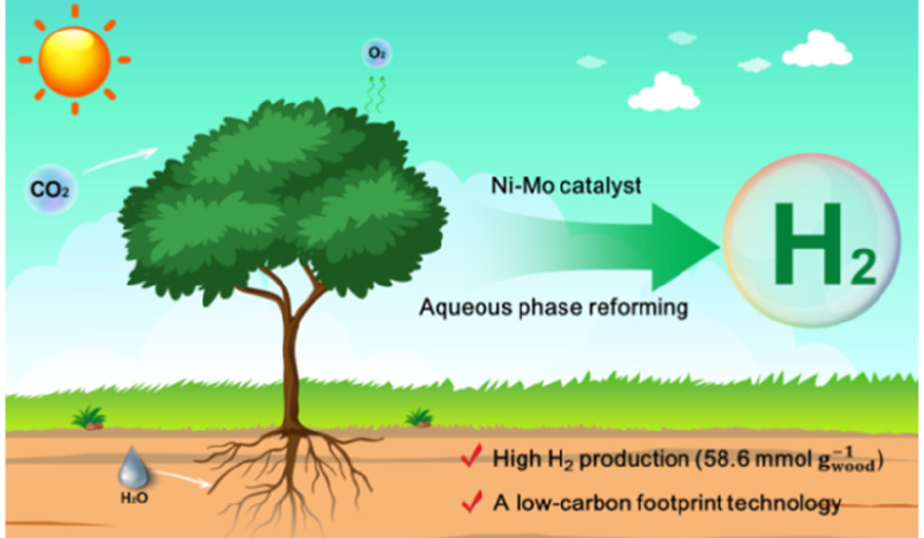
Figure 1. Low-temperature efficient hydrogen production from raw biomass on the Ni–Mo catalyst. reproduced with permission from ref. [12].